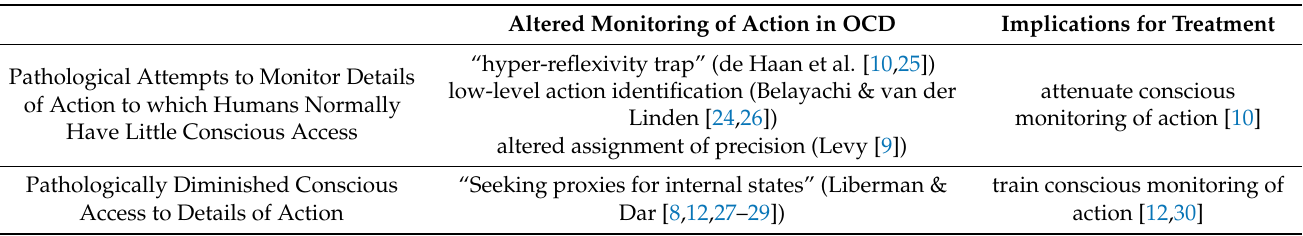
Table 1. Summary of theories of altered subjective experience of sensorimotor function in OCD, together with their implications for treatment. Altered Monitoring of Action in OCD Implications for Treatment Pathological Attempts to Monitor